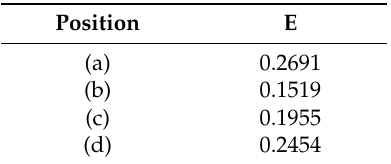
Figure 30. FNFN controller learning curve in the backing control of the car. Table 4. The RMSE of a car backing